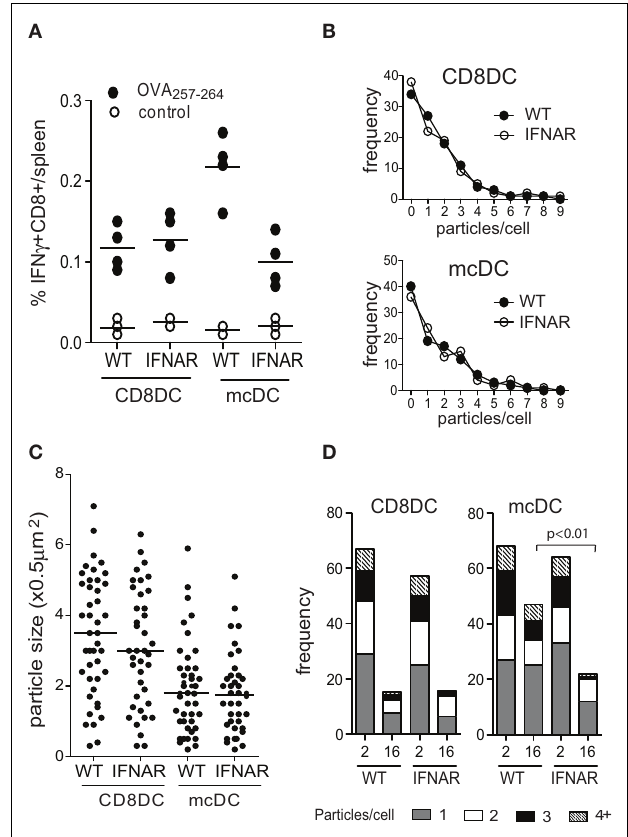
FIGURE 5 |Autocrine type I IFN signaling by mcDC affects CFSE loss on phagocytosed cellular particles suggesting changes in the lysosomal acidification rate. (A) CD8 α DCs and mcDCs from indicated strains were exposed to irradiated actmOVA cells in vitro , purified and transferred into WT recipients. Seven days later the endogenous CD8 + T cell response was analyzed. (B,C) ImageStream analysis comparing the frequency and size of internalized CFSE-labeled particles in CD8 α DCs and mcDCs fromWT and ifnar − / − mice. (D) Loss of delayed acidification in ifnar − / − mcDC as determined by ImageStream analysis using CFSE-labeled irradiated cells and a pulse-chase